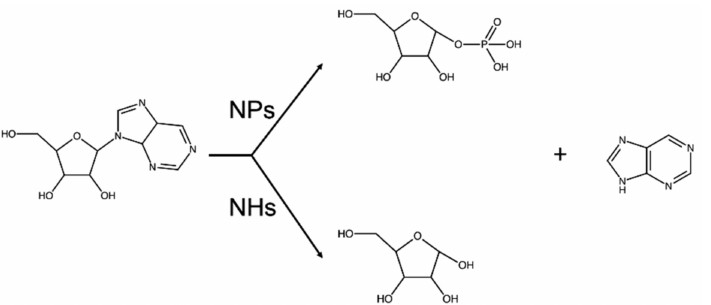
Figure 1. N-ribosidic bond cleavage in biological systems. Phosphorolysis catalyzed by NPs or hydrolysis by NHs of ribosides (here, purine riboside is shown as a general example) releases the nitrogenous base, and either ribose 1-phosphate or ribose is